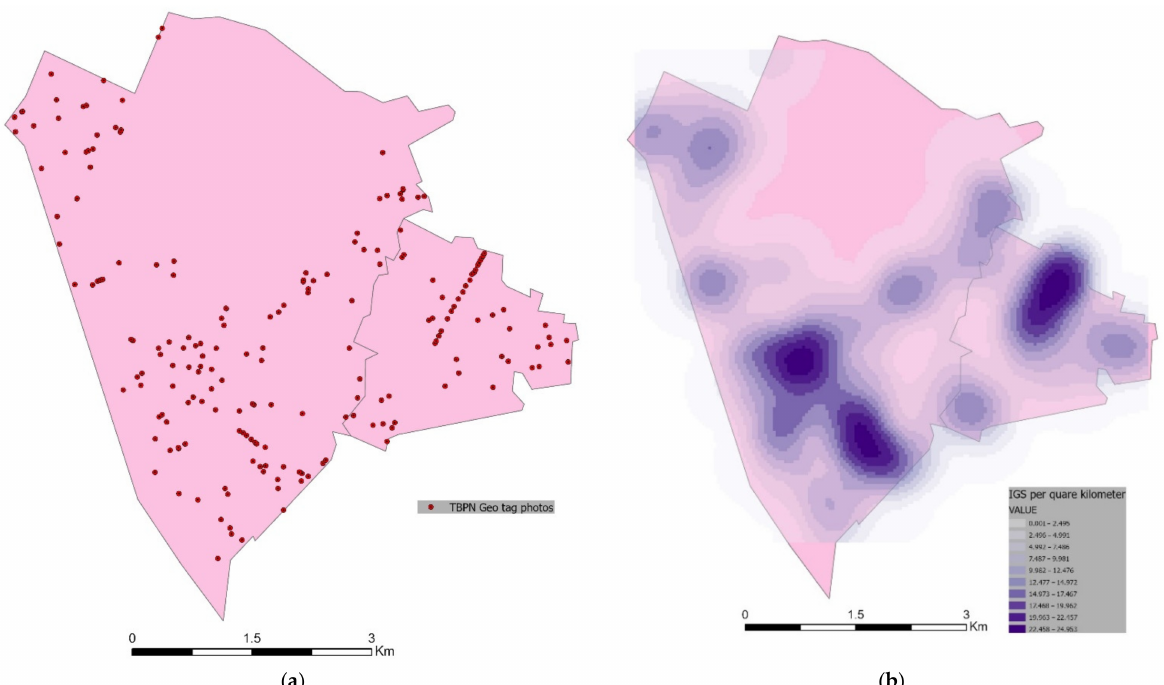
Figure 10. Distribution map ( a ) and density map ( b ) of IGSs in the TBPN districts in HCMC. The IGSs are scattered around two districts; however, there are two particular places: Tan Son Nhat International airport, which restricts the access of ordinary citizens, so no IGS was detected, and a straight line of IGSs at the east of the study areas, which are the IGSs along the railroad. The density heatmap with the dark purple display shows areas with high concentrations of IGSs located in the east and south of the TBPN districts.